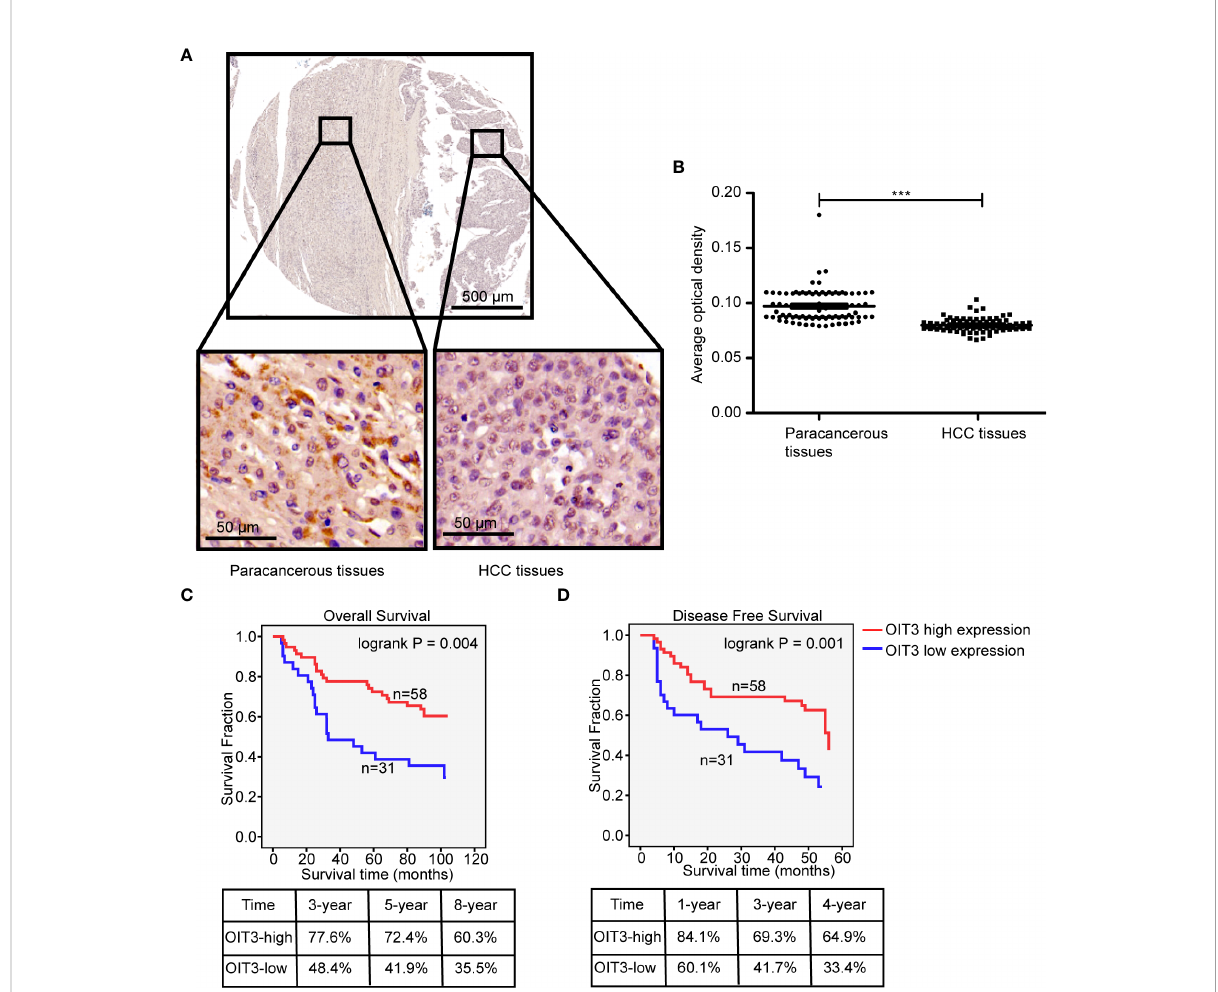
FIGURE 3 OIT3 was lowly expressed in HCC tissues and signi fi cantly correlated with clinical outcomes. (A – B) OIT3 was downregulated in HCC tissues, as validated using ISH with a tissue microarray. As shown, HCC tissues with richer cytoplasms and larger nuclei had weaker OIT3 staining than that in the paracancerous tissues (A) , accompanied by the statistical result (B) (n= 89, ***P < 0.001 ). (C) The clinical outcomes of HCC patients with the different expression levels of OIT3. The 3-, 5-, and 8-year overall survival rates of the OIT3 high group were 77.6%, 72.4%, and 60.3% vs. 48.4%, 41.9%, and 35.3% of the OIT3 low group, respectively. (D) The 1-, 3-, and 4-year disease-free survival rates of the OIT3 high group were 84.1%, 69.3%, and 64.9% vs. 60.1%, 41.7%, and 33.4% of the OIT3 low group,